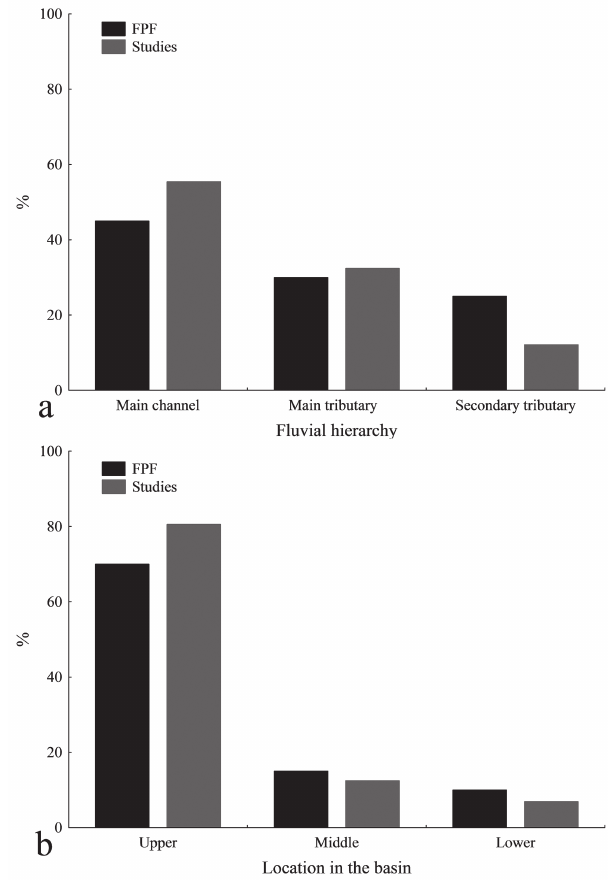
Fig. 2. Proportion of fish passage facilities (FPF) and studies in the different categories of river type and location in the basin. a. fluvial hierarchy; b. location in the basin.